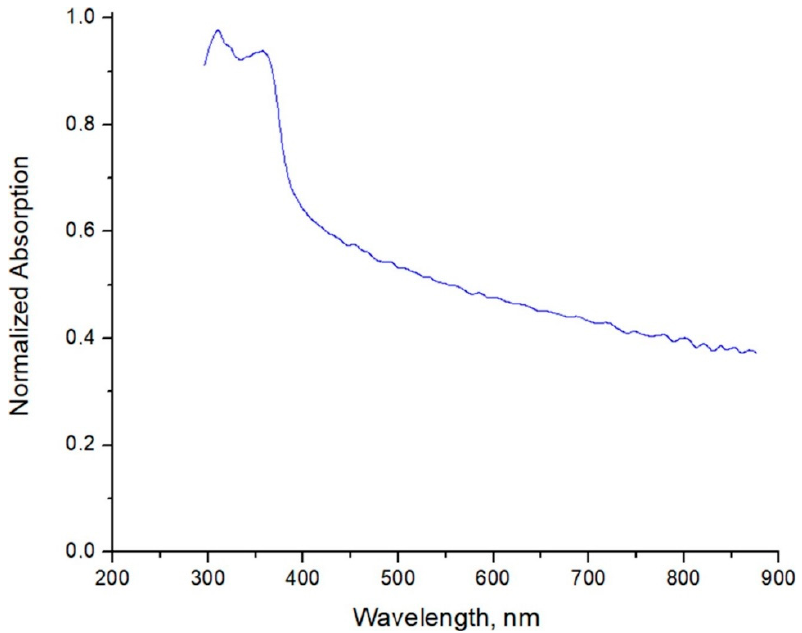
Figure 4. UV-Vis absorption spectra of ZnO-NPs water solution.